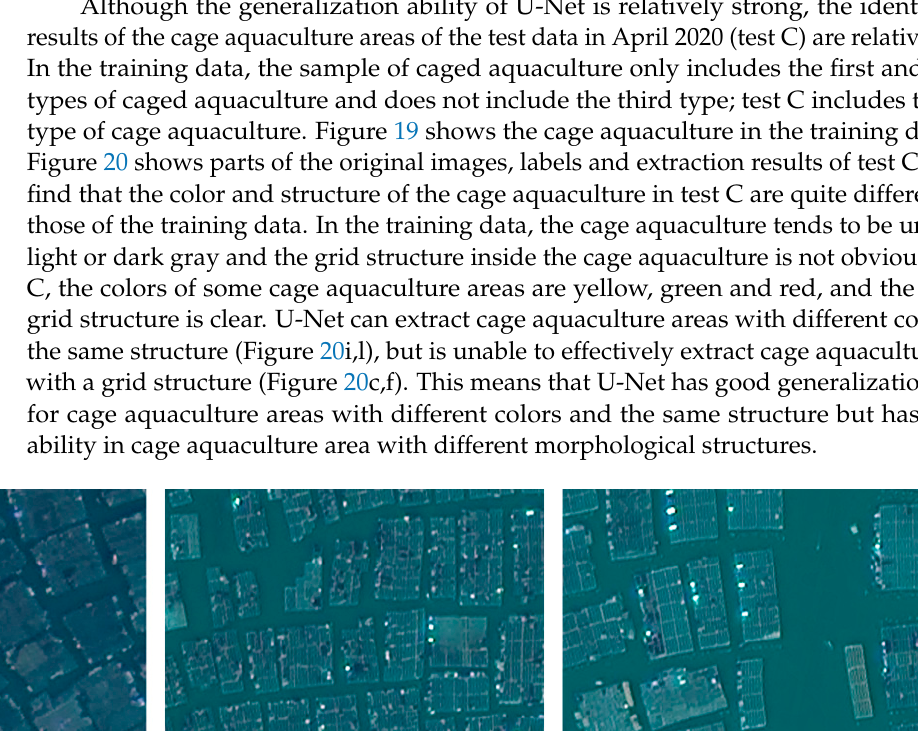
Figure 19. Training data of cage aquaculture. ( a ) The first type of cage aquaculture. ( b , c ) The second type of cage aquaculture.